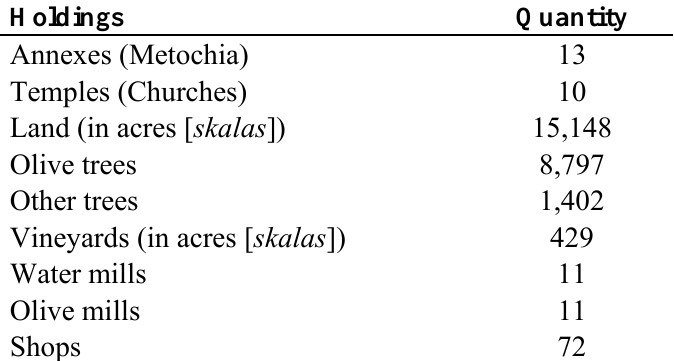
Table 2. Property of the Kykkos Monastery in